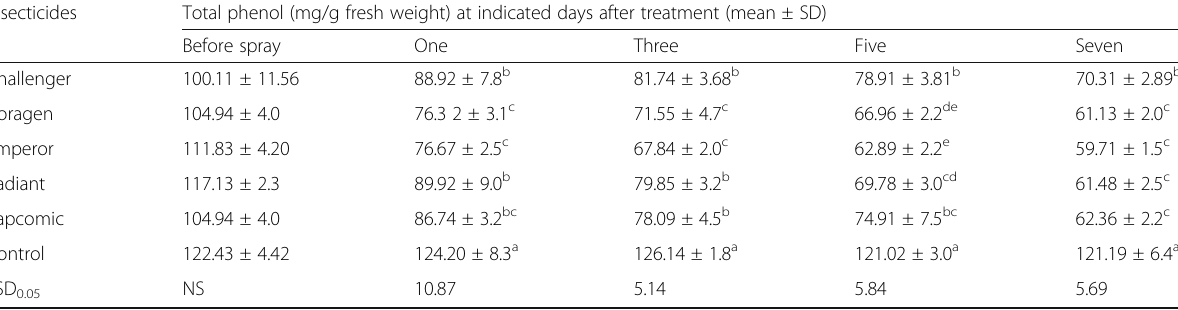
Table 7 Effect of the tested insecticides on total phenol contents of tomato plants